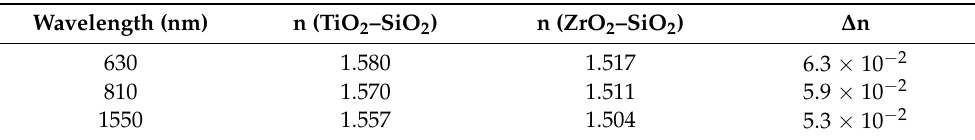
Figure 11. Refractive index of TiO 2 –SiO 2 (red line) and ZrO 2 –SiO 2 (black line) obtained by the ellipsometry technique. The layers were insolated by UV photons and thermally treated. Table 2. Refractive index (n) obtained for TiO 2 –SiO 2 and ZrO 2 –SiO 2 films. The corresponding ∆ n is given for the three wavelengths of interest: 630, 810 and 1550 nm.